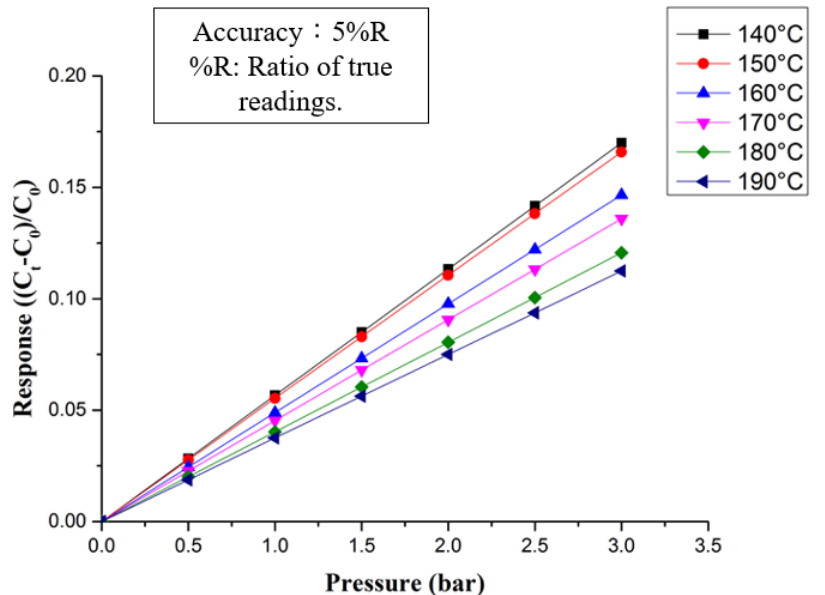
Figure 7. Dimensionless calibration curve of micro pressure sensor.